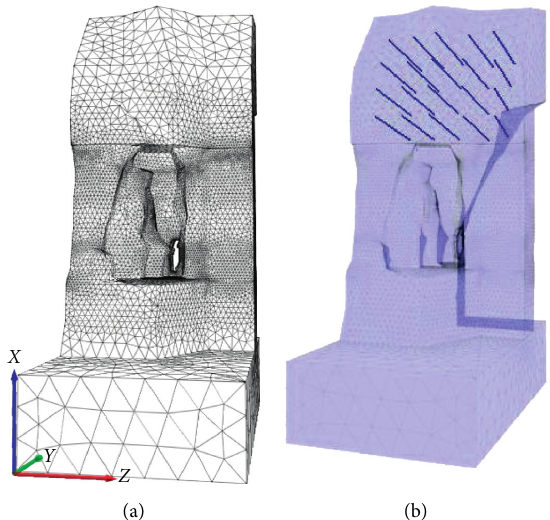
Figure 4: Numerical model: (a) numerical model of the unanchored grotto and mesh generation; (b) schematic of bolt support